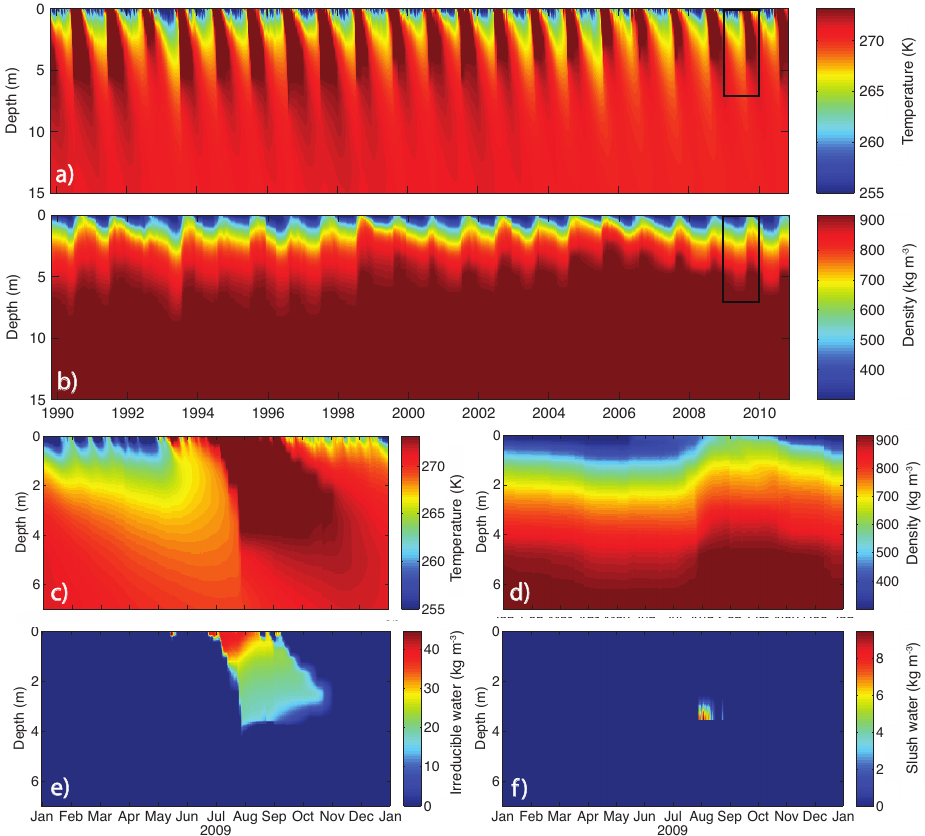
Fig. 8. The upper two panels show time-series of the simulated subsurface temperatures (a) and densities (b) at stake site S9 over the period 1989–2010. The lower four panels focus on the temperature (c) , density (d) , irreducible water (e) and slush water content (f) evolution in 2009 over the time and depth range marked by the black box in the upper two panels.